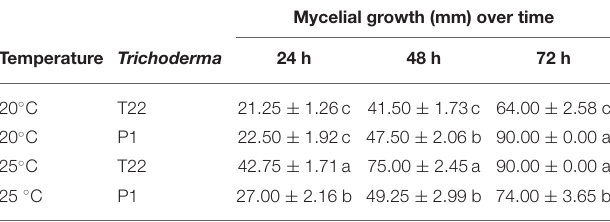
TABLE 1 | Effect of temperature (20 ◦ C and 25 ◦ C) on the mycelial growth (colony diameter in mm) of Trichoderma strains T22 and P1 cultured on PDA, measured at 24h